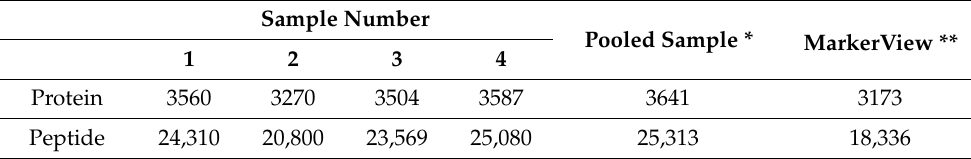
Table 1. Protein and peptide identification in retinal samples 2 weeks after